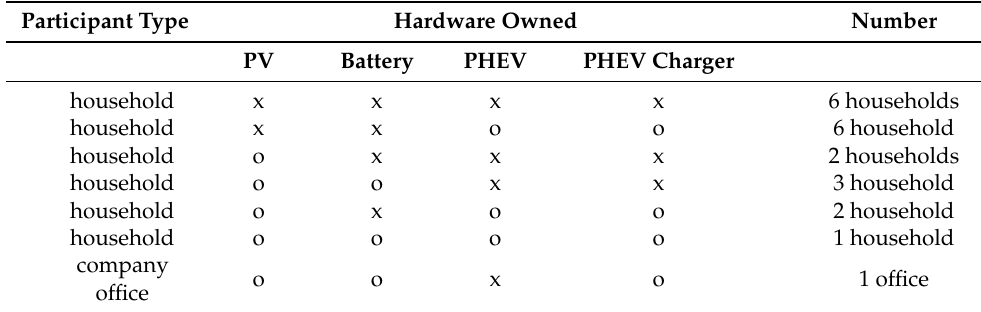
Table 6. Demonstration Experiment